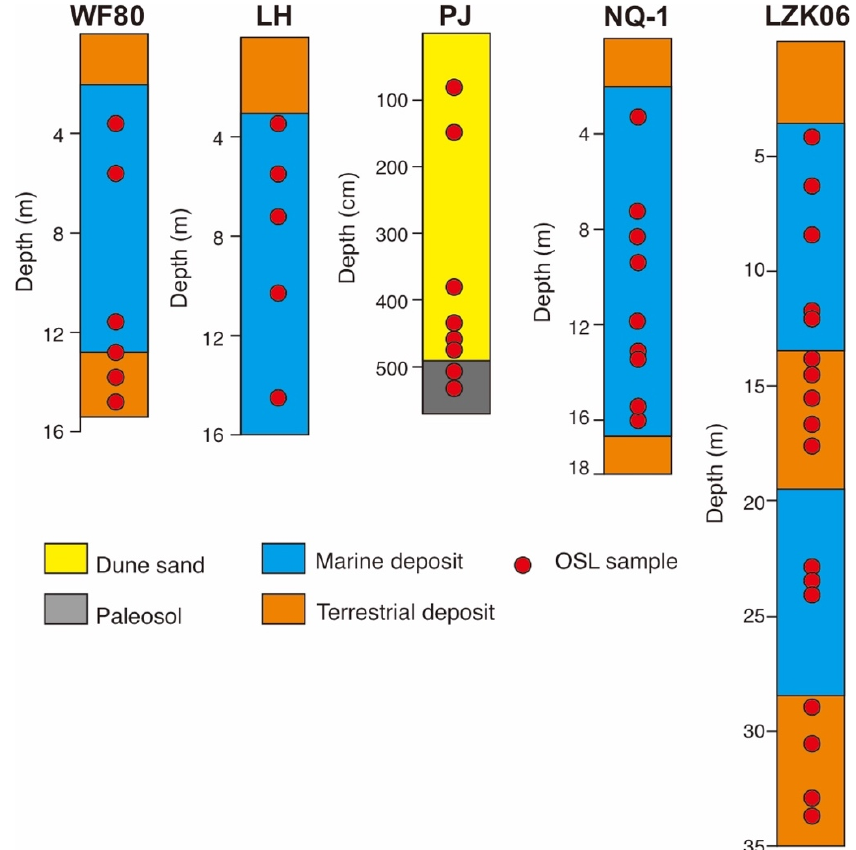
Figure 2. Lithology and depths of the OSL samples.